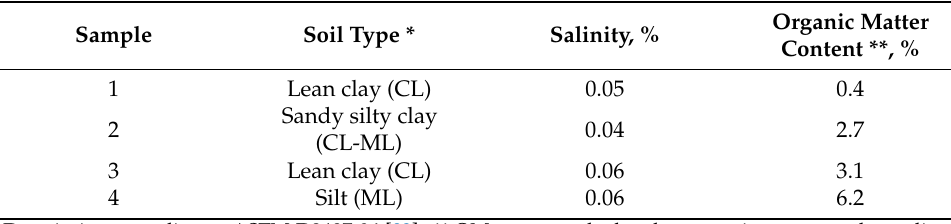
Table 2. Salinity and organic content in soil samples from northern West Siberia. Sample Soil Type * Salinity, %